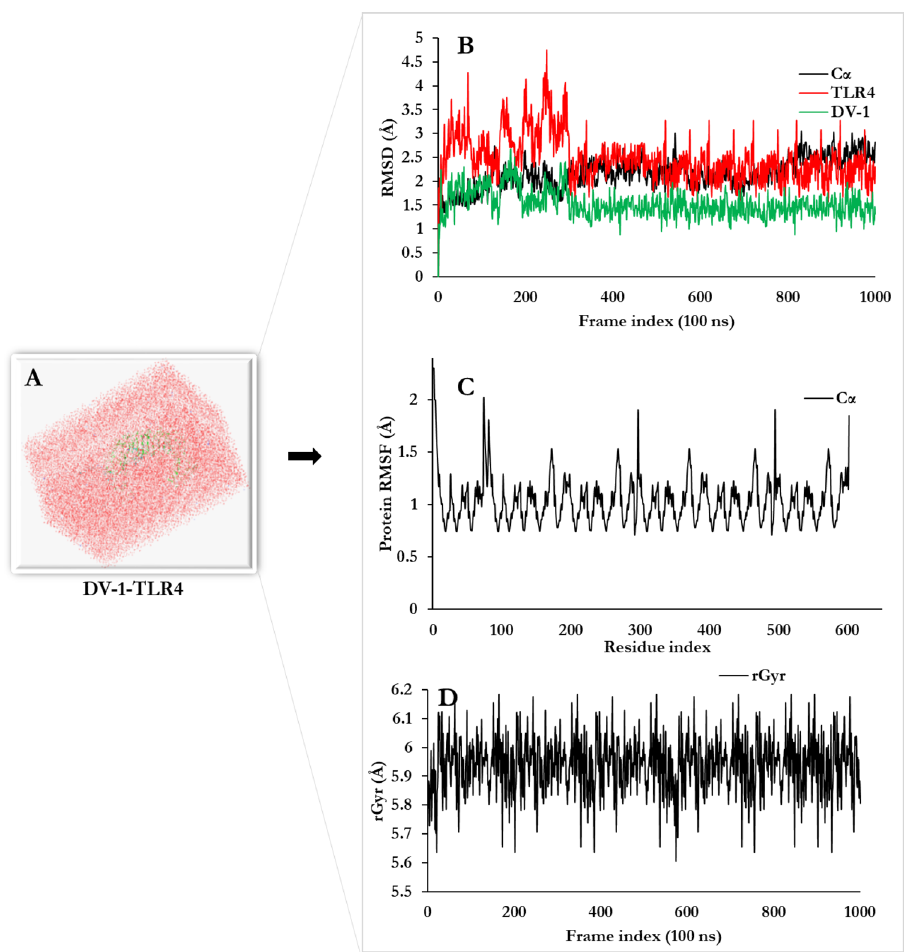
Figure 11. Molecular dynamics simulation of (DV-1-TLR-4 complex at 100 ns (ns). ( A ) Molecular dynamics trajectory (system set-up for the simulation), ( B ) Root Mean Square Deviation of docked complex shows very minimal deviation which reflects the stable microscopic interaction between DV1 and TLR4 molecule ( C ) RMSF-Root Mean Square Fluctuation plot of docked protein complex side chain fluctuation in plot generates peak which reflects the flexibility of side chain of docked protein complex. ( D ) Time evolution of the radius of gyration (rRyr) during 100 ns of MD